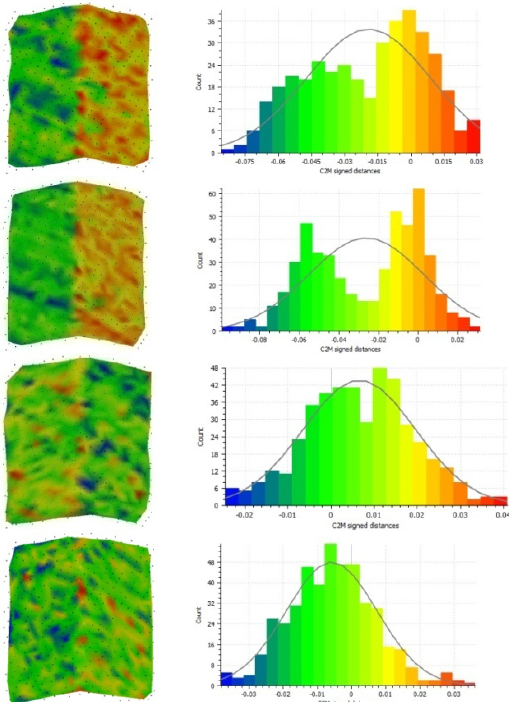
Figure 10. Meshed building roof (left) and corresponding histogram of signed cloud-to-mesh distances (right) for flight strip one, two, three and four (top to bottom) The flight strips three, four and five show the best match. The other two flight strips are shifted about 4 to 5 cm downwards approximately along the right roof area. The roof points of strip three show a small shift which is not obvious from the road